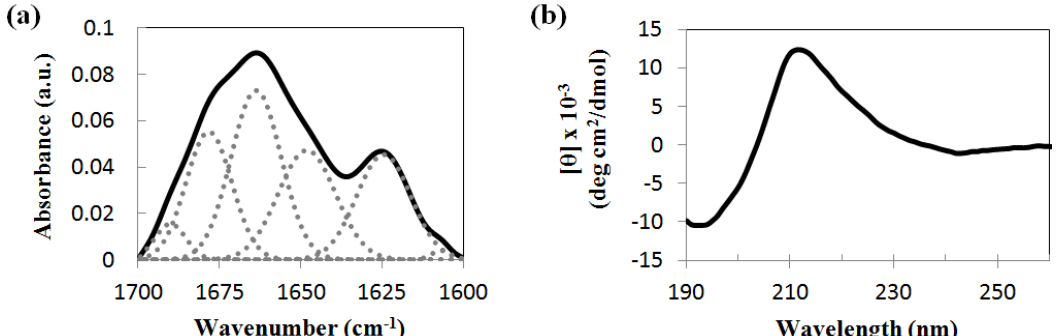
Figure 4. Secondary structure analysis of Asp-DOPA-Asn-Lys-DOPA. ( a ) Fourier transform infrared (FTIR) spectrum of dried 6 mM solution sample. The spectrum was analyzed by curve-fitting the second derivative of the amide I’ region; ( b ) circular dichroism (CD) spectrum of 3 mM solution at 25